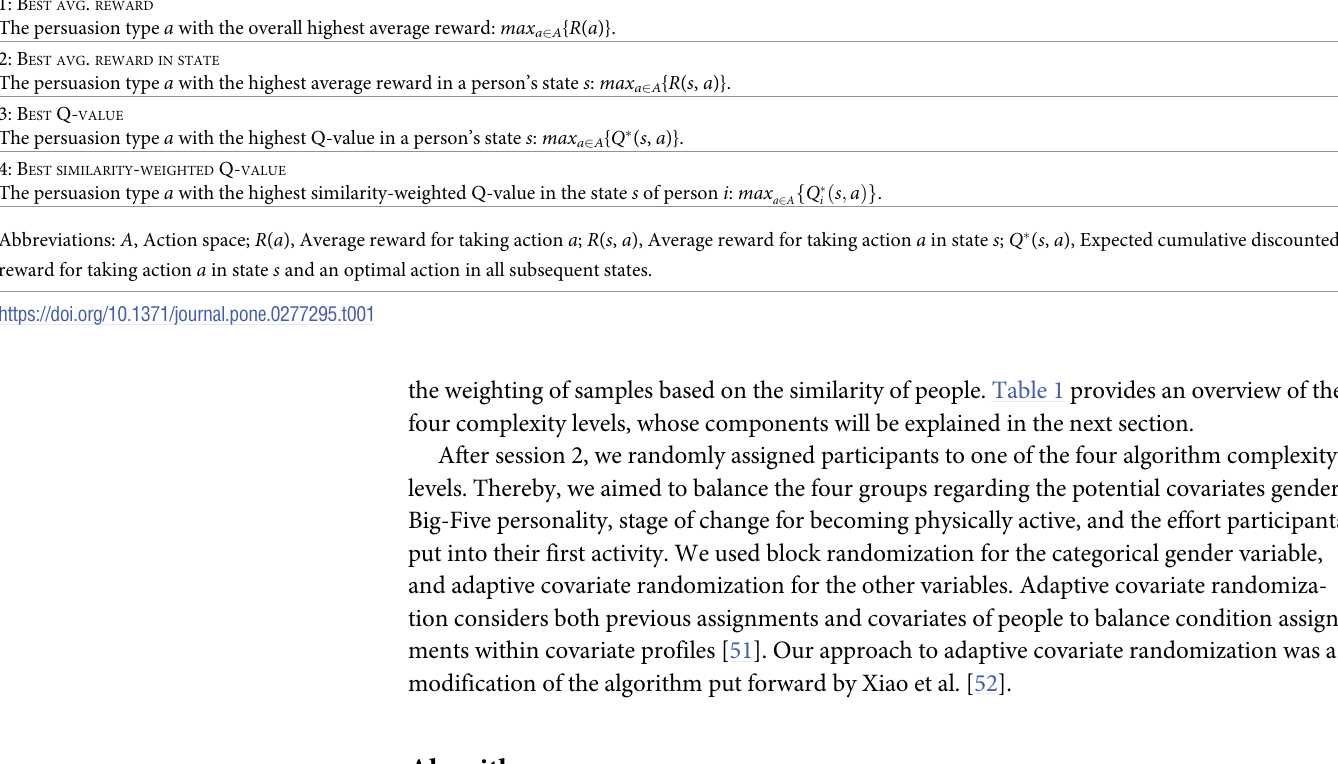
Chosen Persuasion